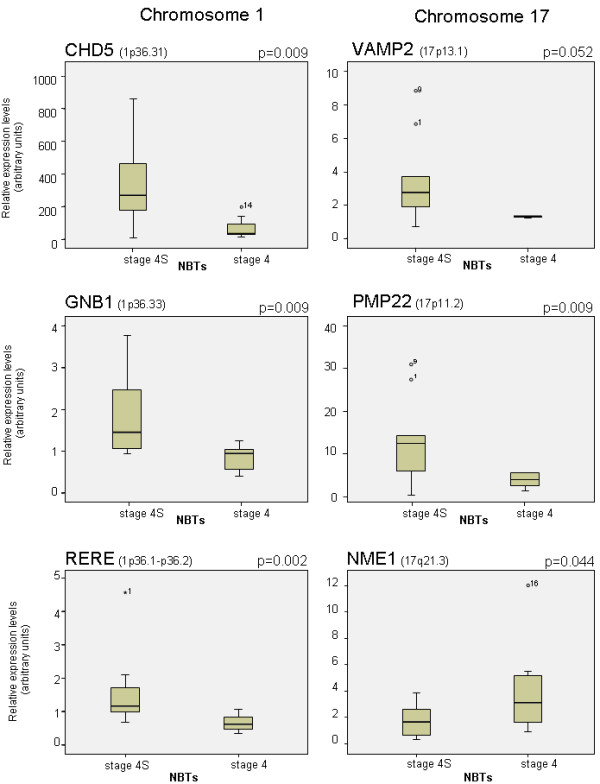
Quantitative real-time PCR validation of microarray gene expression data. Comparison of gene expression levels of 6 representative genes located on chromosomes 1 and 17 for 19 infant NB tumours (12 stage 4s and 7 stage 4 < 18m). Results were compared by two-tailed independent-sample t test using SPSS v.14.0 for Windows (SPSS, Chicago, IL). Expression data are shown as box plots (SPSS v.14.0).